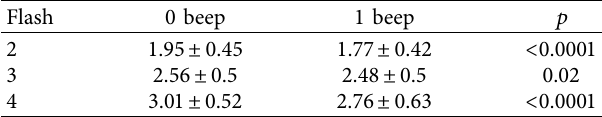
Table 4: Comparison between 0B and 1B trials showing fusion illusory effect in all participants. Data are plotted in the Figure